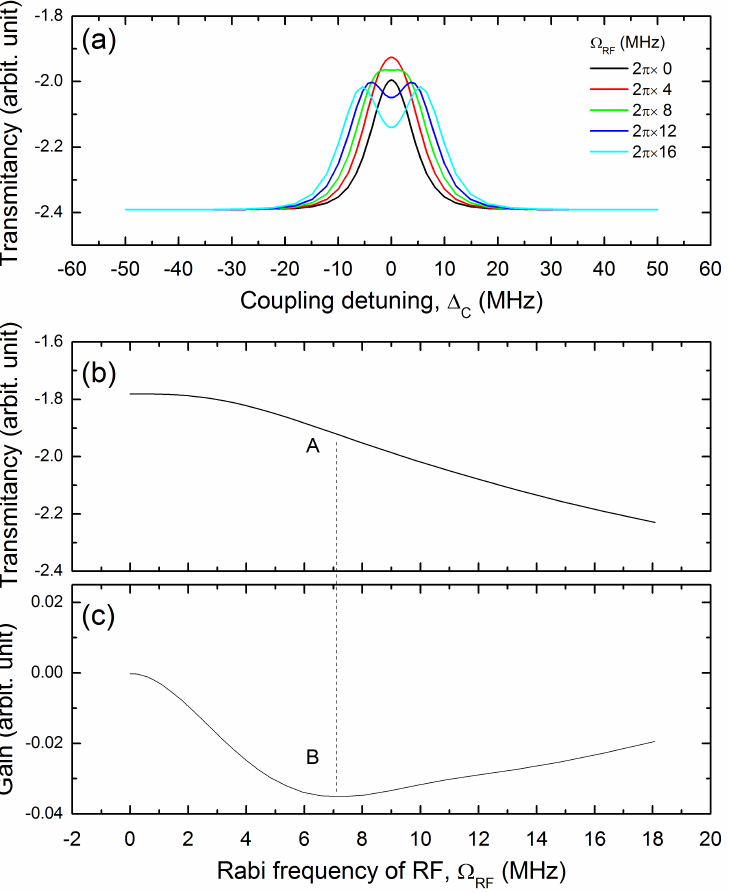
Figure 2. ( a ) Theoretical simulation of the probe transmittancy by scanning the coupling laser based on the optical Bloch equation at various RF strengths, ( b ) the probe transmittancy dependent on the RF strength at zero coupling detuning and its derivative depicting its RF-optical gain. The point A in ( b ) and B in ( c ) corresponds to the maximum gain where the RF strength is 2 π × 7